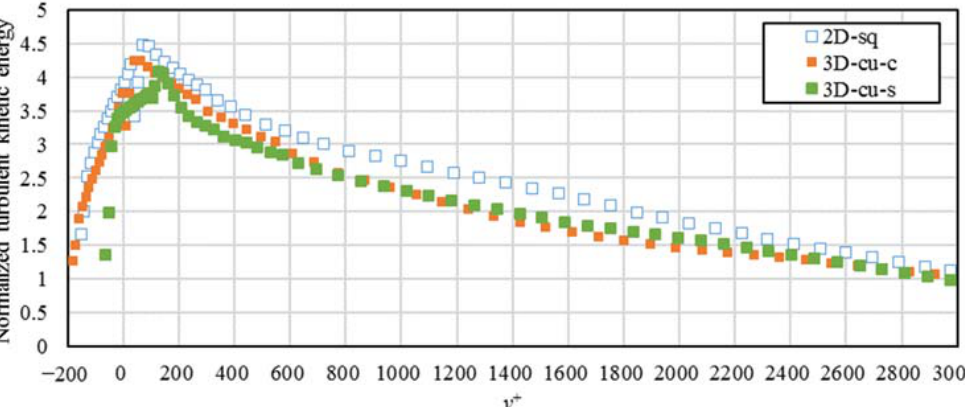
Figure 9. Normalized turbulence kinetic energy profiles averaged over roughness elements.